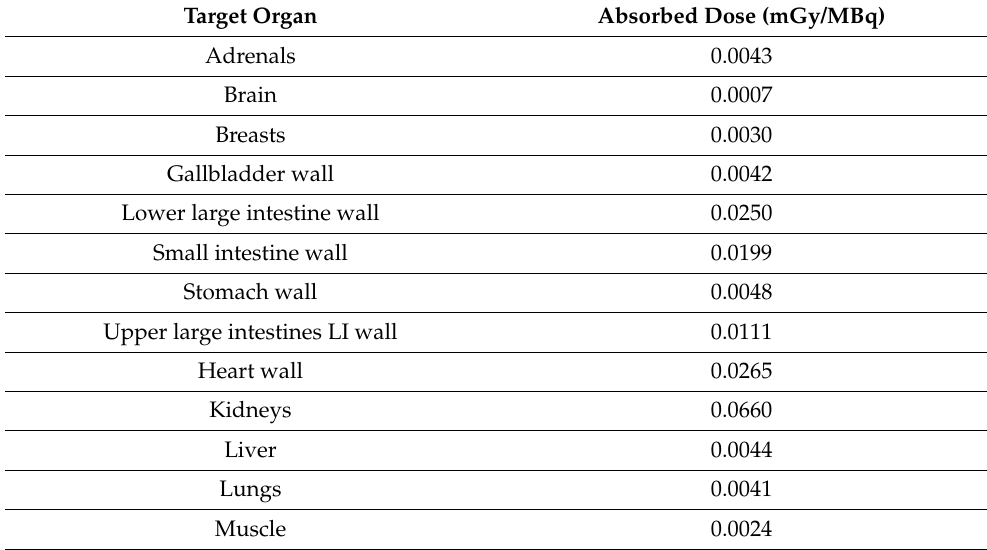
Table 1. The absorbed dose (mGy/MBq) of [ 68 Ga]Ga-BQ7812 in each of the targeted